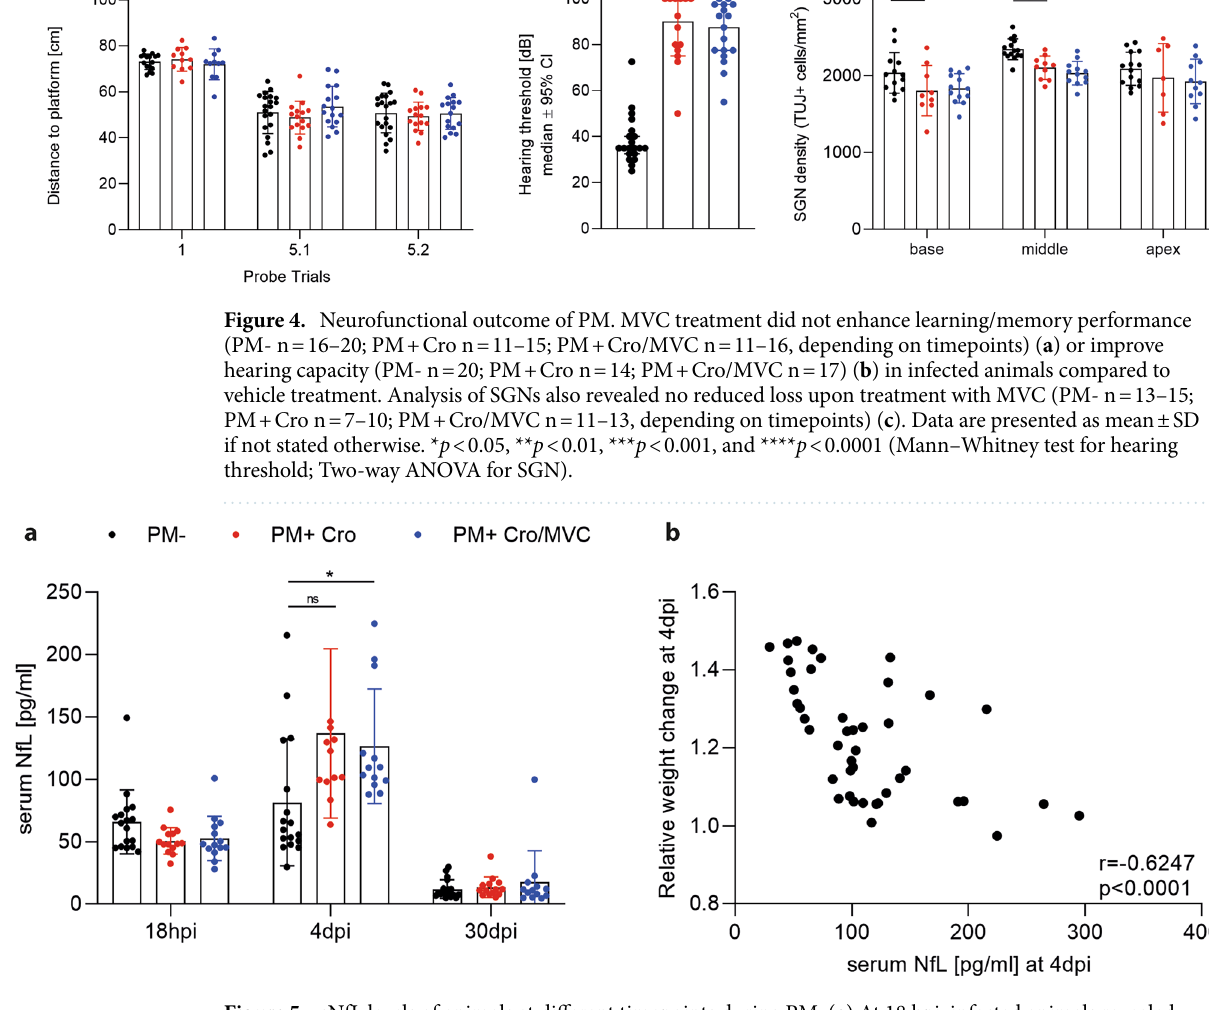
Figure 5. sNfL levels of animals at different timepoints during PM. ( a ) At 18 hpi, infected animals revealed similar sNfL levels compared to mock-infected animals. The sNfL levels of infected animals rose at 4 dpi and decreased again at 30 dpi to similar levels as found in mock-infected ones. MVC treatment did not affect sNfL at any given timepoints (PM- n = 17–18; PM + Cro n = 13–14; PM + Cro/MVC n = 13–14, depending on timepoints). ( b ) At 4 dpi, sNfL levels and relative weight change of the animals correlated (n = 43). Data are presented as mean ± SD. * p < 0.05, ** p < 0.01, *** p < 0.001, and **** p < 0.0001 (Two-way ANOVA; Spearman